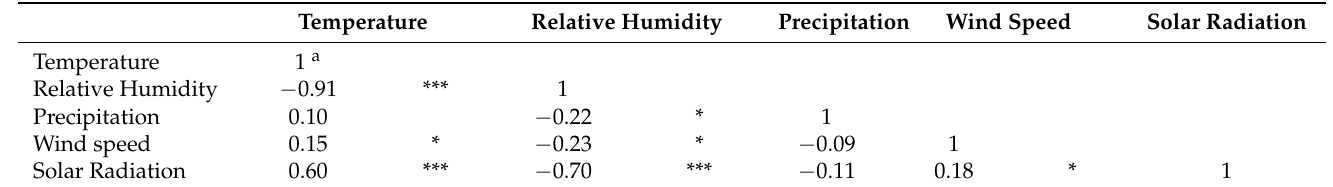
Table 2. Pearson moment correlation (r) matrices between five weather variables documented from April to August 2019 in 25 maize-growing governorates of Egypt from which grain samples were gathered (one weather